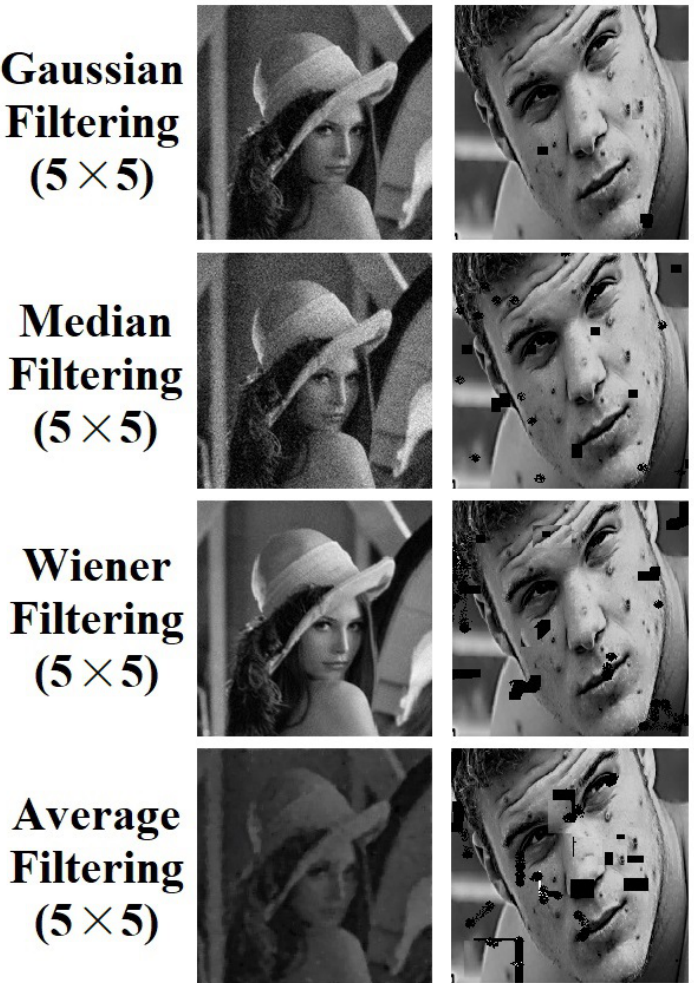
Figure 12. The watermarking results achieved by the proposed approach when applied to the Lena